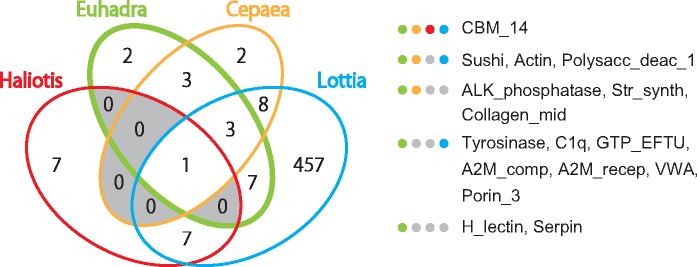
—Comparisons of domains of SMPs among four gastropods Euhadra quaesita, Cepaea nemoralis, Haliotis asinina, and Lottia gigantea. Carbonic anhydrase binding motif 14 (CBM_14) is a major domain in SMPs of the four gastropods. Three domains are conserved within three species (except for H. asinina), and four domains are conserved within pulmonate (E. quaesita and C. nemoralis). ALK_phosphatase, alkaline phosphatase; A2M_com, a-macroglobulin compliment component; A2M_recep, a-macroglobulin receptor; Collagen_mid, bacterial collagen middle region; C1q, compliment component 1q; GTP_EFTU, elongation factor Tu GTP binding domain; H_lectin, H-type lectin domain; Polysac_deac_1, polysaccharide deacetylase; Porin_3, eukaryotic porin; Str_syn, strictosidine synthase; Sushi, sushi repeat domain; VWA, von Willebrand factor type A domain.